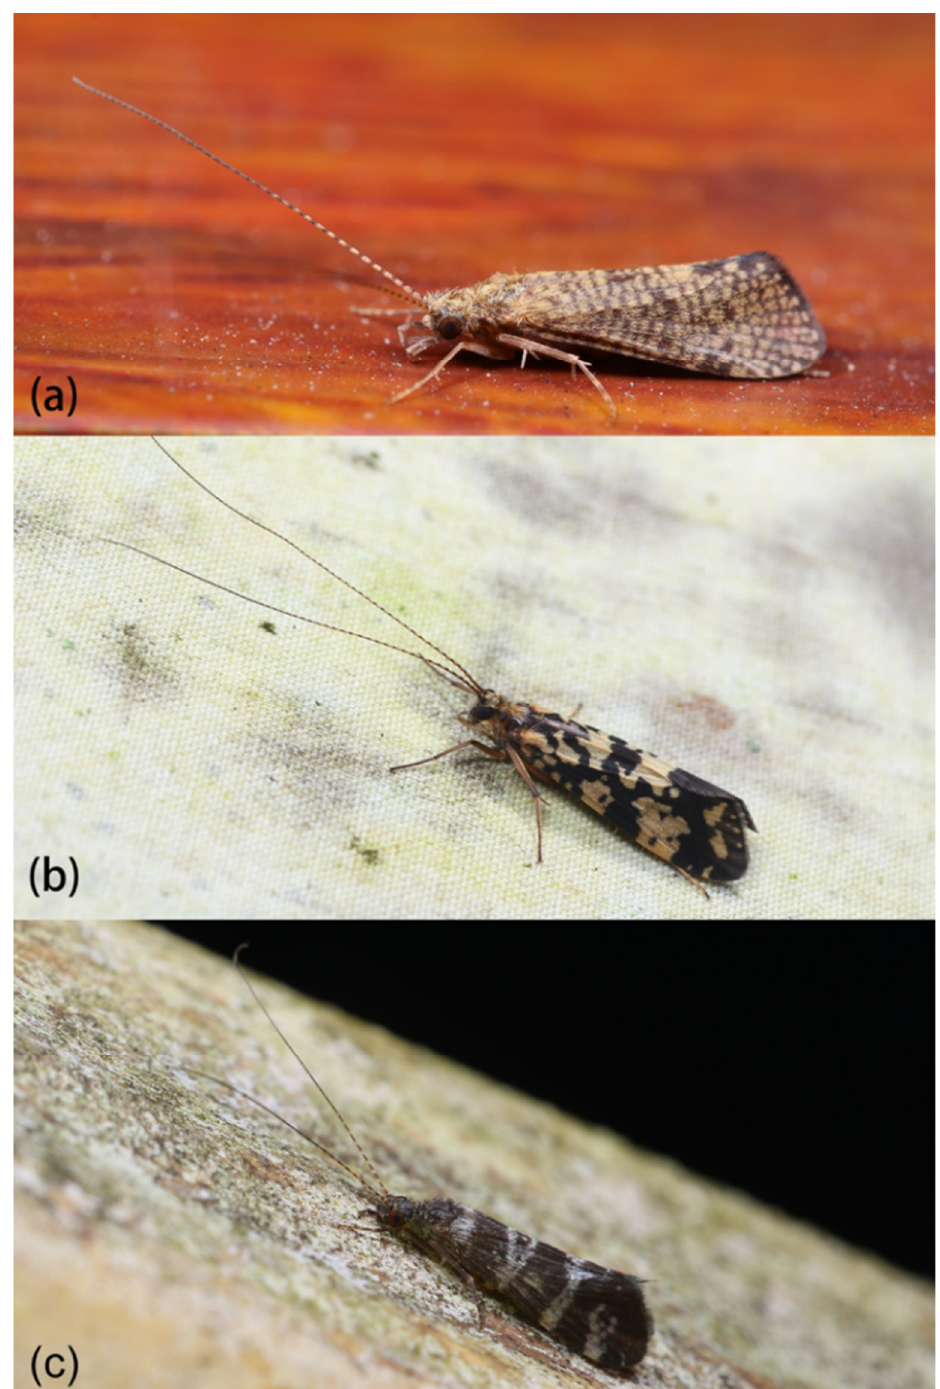
Figure 1. Live adults of hydropsychid species. ( a ) Hydropsyche sp., female, from Guangdong, China; ( b ) Hydromanicus sp., female, from Guangdong, China; ( c ) Cheumatopsyche sp., male, from Guangdong, China (( a – c ) photographed by Qianle Lu).